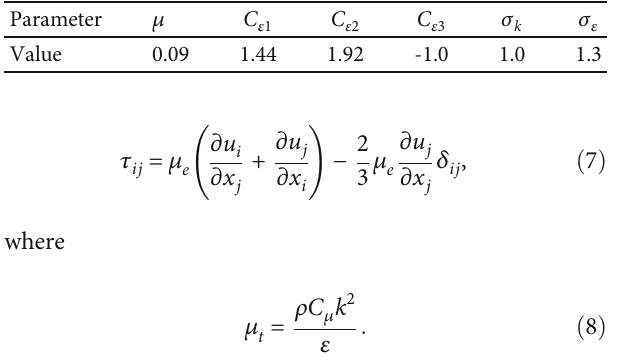
Figure 2: The geometry size of the thrust chamber, injector, and plenum Table 1: Turbulence model coe ffi cients.